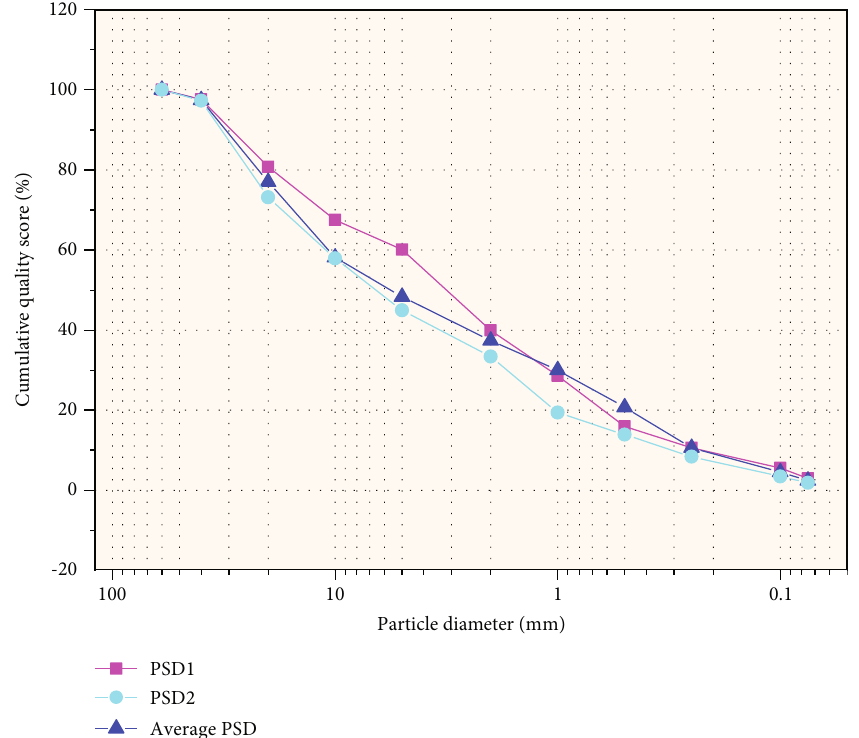
Figure 3: Nature grain-size distribution curve of clay gravel layer.